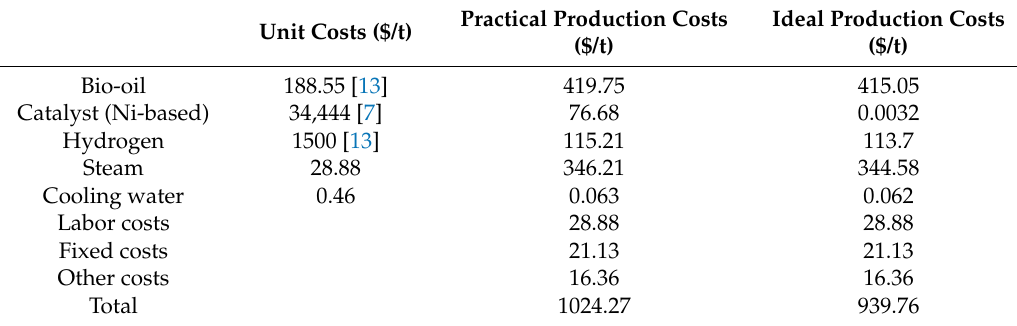
Table 5. Estimation of raw material costs for the two cases